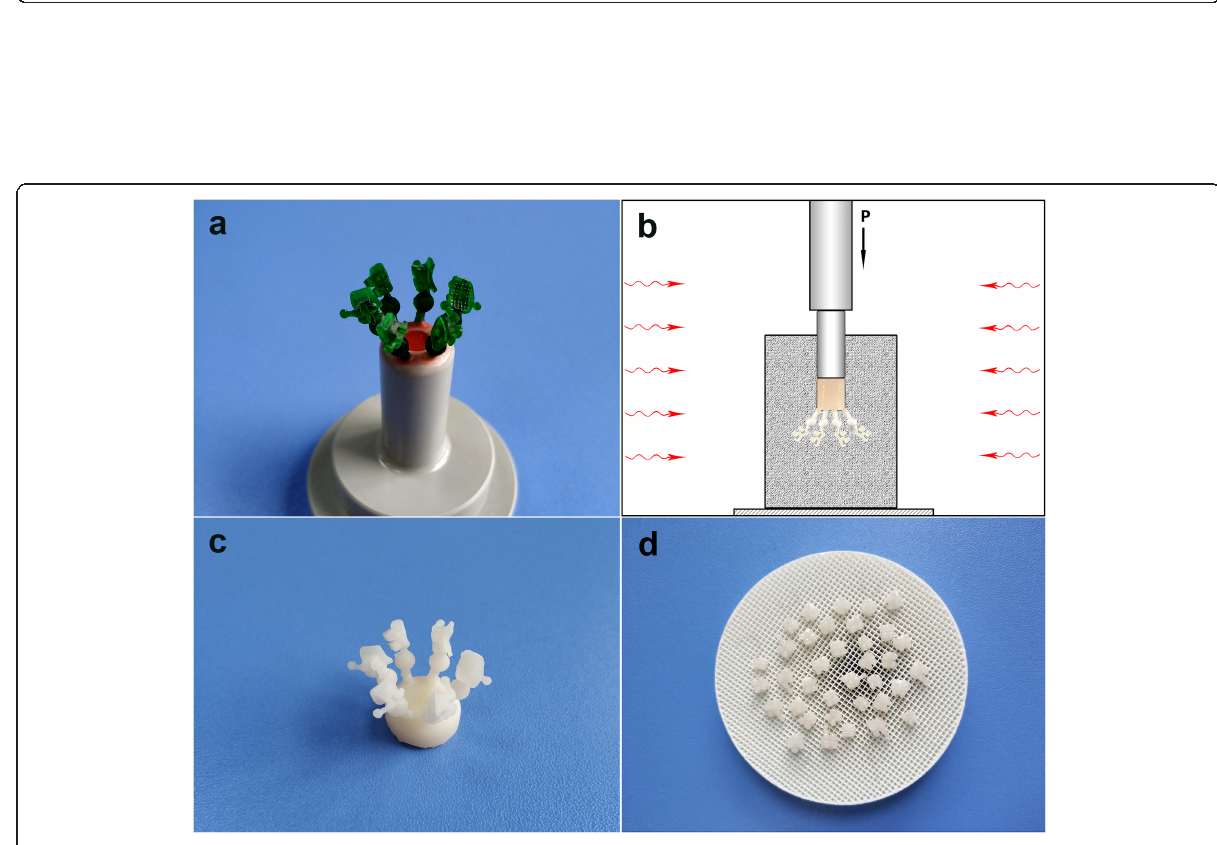
Fig. 1 Virtual construction of customized bracket modeling: a digital modeling of initial teeth; b digital modeling of rearrangement teeth; c generating customized bracket bases and body; d separating bracket and adding a sprue on side face